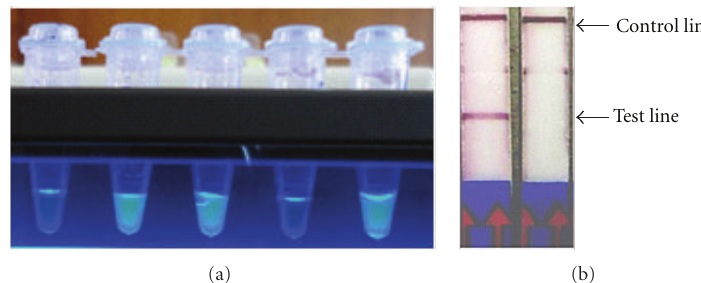
Figure 3: (a) visualisation LAMP products by fluorescence. To the extreme left and right are the negative and positive controls respectively. The 2 samples next to the negative control were from T. b. rhodesiense HAT cases, the one next to positive control is from a non-HAT infected individual. (b) detection of RIME LAMP amplification product using doubled labelled Milenia Genline Hybridetect 2 lateral flow strips. Product detection is achieved through hybridisation of fluoresceine isothiocyanate (FITC)-labeled probe with biotinylated LAMP product followed by combination with gold-labeled anti-FITC forming a triple-labeled complex which moves up the strip and is captured by an immobilized biotin-binding protein (test line). The nonhybridized FITC probe binds to the gold-labeled anti-FITC to form a double complex without biotin and is trapped at the control line. The faint line between the test control lines is nonspecific binding at DIG test